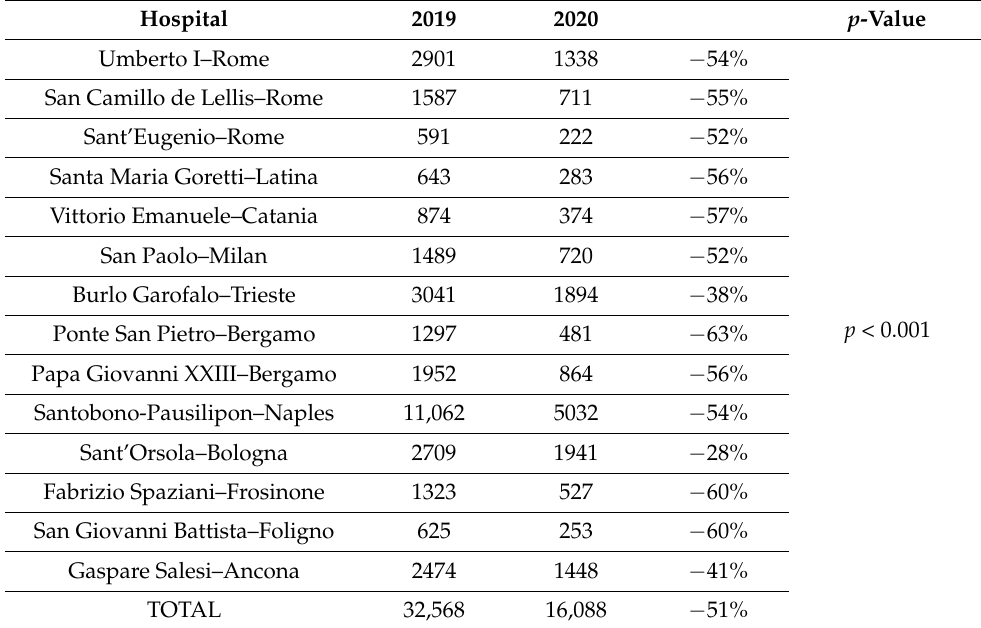
Latina (643 vs. 283); Vittorio Emanuele hospital, Catania (874 vs. 374); San Paolo hospital, Milan (1489 vs. 720); Burlo Garofalo hospital, Trieste (3041 vs. 1894); Ponte San Pietro hospital, Bergamo (1297 vs. 481); Papa Giovanni XXIII hospital, Bergamo (1952 vs. 864); Santobono-Pausilipon hospital, Naples (11,062 vs. 5032); Sant’Orsola hospital, Bologna (2709 vs. 1941); Fabrizio Spaziani hospital, Frosinone (1323 vs. 527); San Giovanni Battista hospital, Foligno (625 vs. 253); and Gaspare Salesi hospital, Ancona (2474 vs. 1448). Comparing total ER visits from 24 September to 6 November 2020, with those from 24 September to 6 November 2019, we observed a reduction rate of 51% (32,568 vs. 16,088 visits, respectively) ( p < 0.001) (Table 1). Table 1. ER visits registered in September–November, 2019 and 2020.